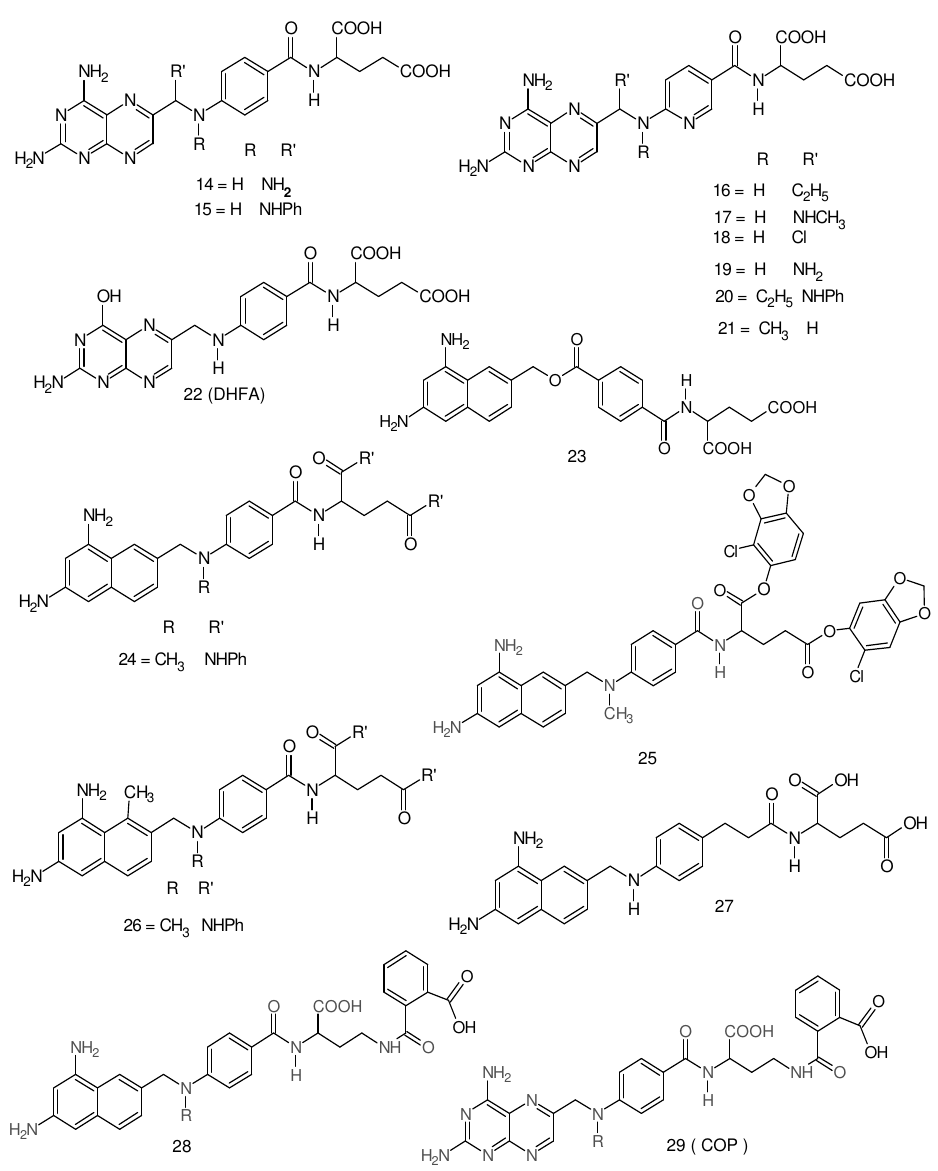
Figure 2. Top ranking ligand